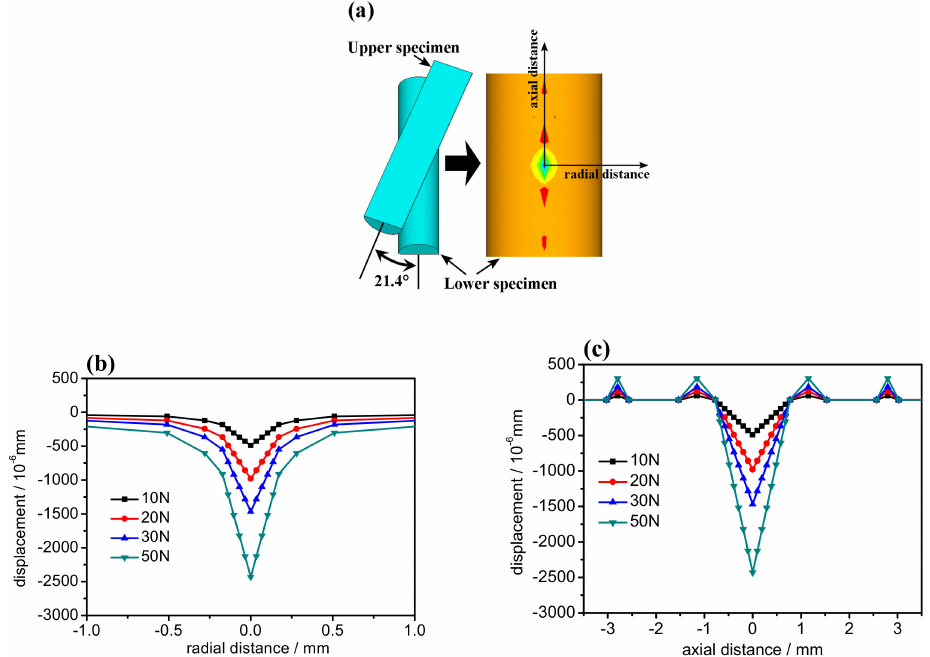
Figure 2. Finite element analysis of contact state: ( a ) simplify model used, ( b ) displacement changes in radial direction, and ( c ) displacement changes in axial